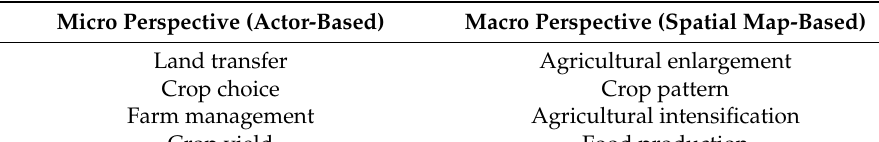
Table 1. Advanced ALS studies by integrating deferent research perspectives.